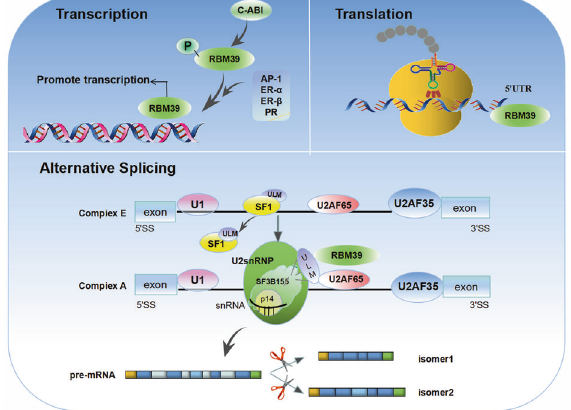
Fig. 2 Schematic diagram of the function of RBM39 in cancer cells. RBM39 participates in the regulation of gene expression from multiple levels, including transcription, alternative splicing, and